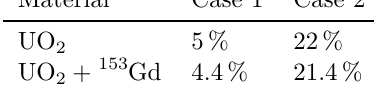
Table 2. Enrichment of UO